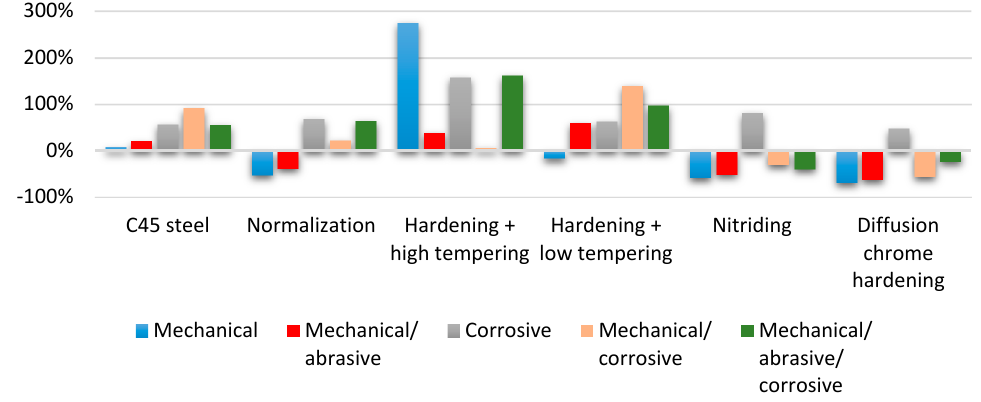
Figure 11. The change of the Rv parameter value obtained after friction tests to the value before the wear test.